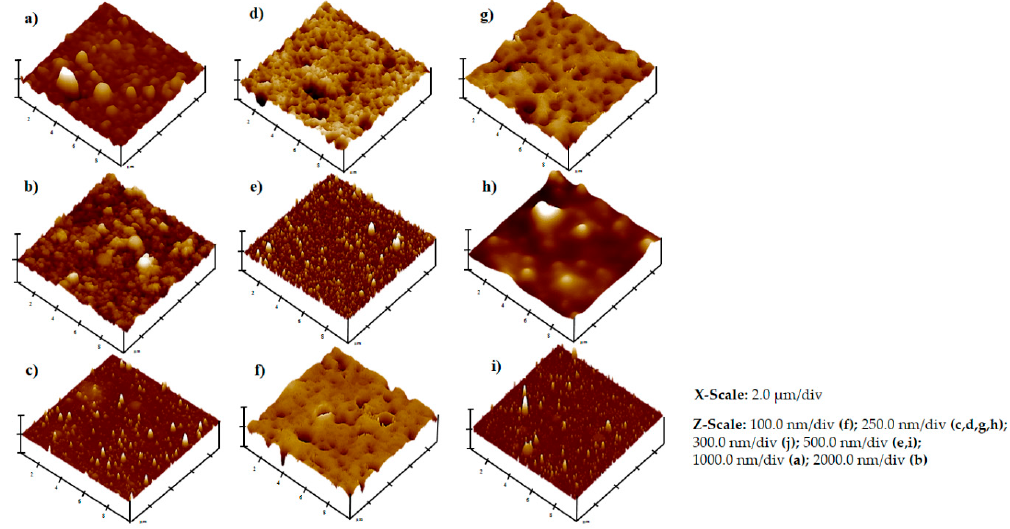
Figure 3. Surface data for MAPLE-deposited thin films, including 10 × 10 µm 2 atomic force microscope (AFM) scans, root mean square (RMS) roughness, and Z-range values: ( a ) polyvinylpyrrolidone, ( b ) polyvinylpyrrolidone–quercetin dihydrate, ( c ) polyvinylpyrrolidone–quercetin dihydrate–amphotericin B, ( d )polyvinylpyrrolidone–quercetindihydrate–voriconazole,( e )polyvinylpyrrolidone–resveratrol–voriconazole,( f ) polyvinylpyrrolidone–resveratrol–amphotericinB,( g )polyvinylpyrrolidone–resveratrol,( h )polyvinylpyrrolidone– voriconazole, and ( i ) polyvinylpyrrolidone–amphotericin B. Table 1. Atomic force microscope (AFM) surface roughness analysis of thin film surfaces. Roughness Parameter